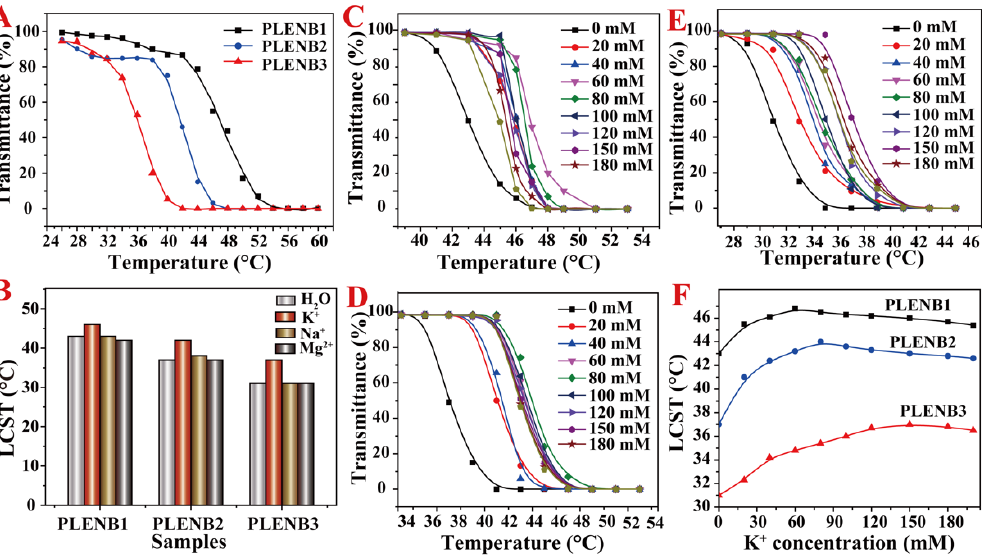
Figure 3. The UV − vis transmittance curves of PLENB changed with temperature in KCl solution ( A ); the LCST of PLENB in different ion solution ( B ); the transmittance curves of PLENB1 ( C ), PLENB2 ( D ), PLENB3 ( E ), and the LCST curves ( F ) of PLENB with different K + concentration in different